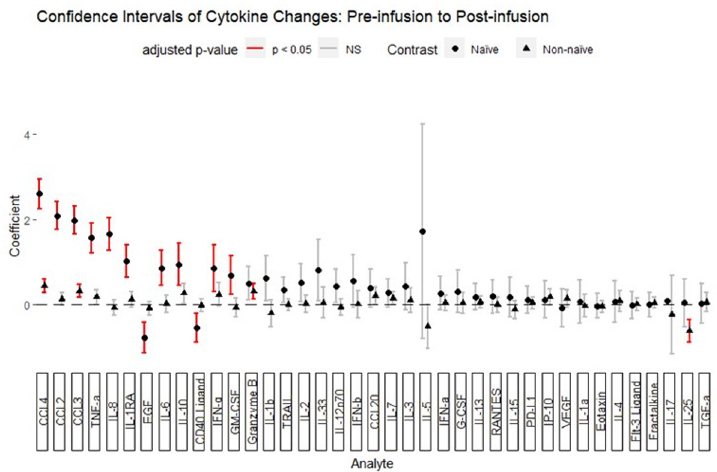
Fig 4. Statistically-significant cytokine changes between the pre-infusion and post-infusion blood draws plot of the mean (dot) and confidence interval (whiskers) for the coefficients of the pre-infusion to post-infusion interval. Subjects were separated by whether IVIG treatment was initiated during the study (na ï ve) or if the subject was already receiving IVIG regularly (non-na ï ve). P-values for coefficients were adjusted by the Benjamini-Hochberg method. Adjusted p-values < 0.05 are highlighted in